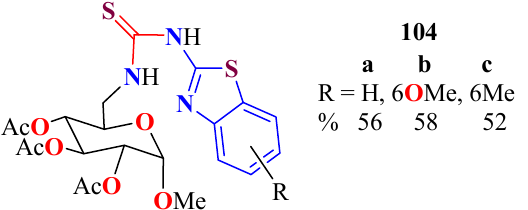
Figure 14. Substituted-sugar-TBTs 104 used as intermediates in the synthesis of substituted-sugar- GBTs.